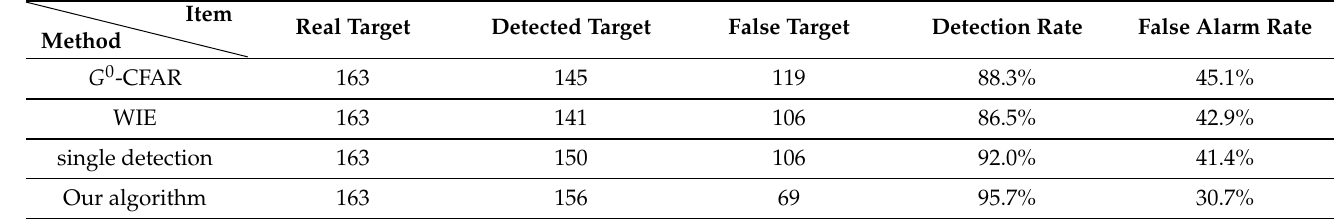
Table 1. Comparison of SAR image target detection